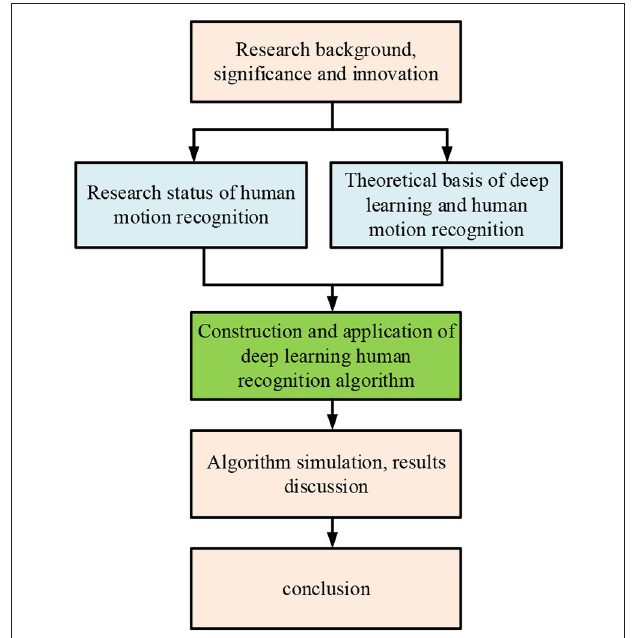
FIGURE 1 | The organizational